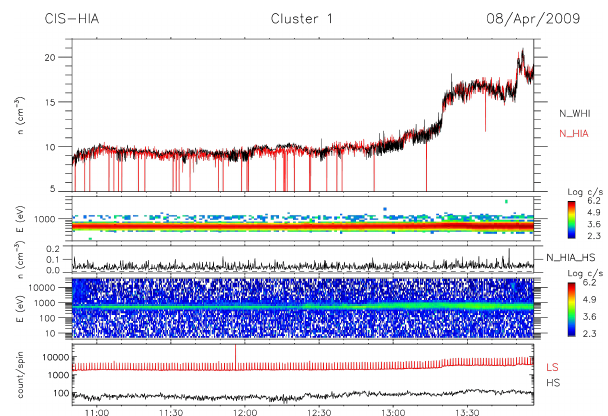
Fig. 5. Standard plot used for identification of suitable HIA LS cal- ibration intervals. From top to bottom, the individual panels present HIA (red) and WHISPER (black) raw density data, the energy spec- trogram provided by the LS section, the number density based on data collected by the HS section, the energy spectrogram provided by the HS section, and the number of counts detected by LS (red) and HS (black)